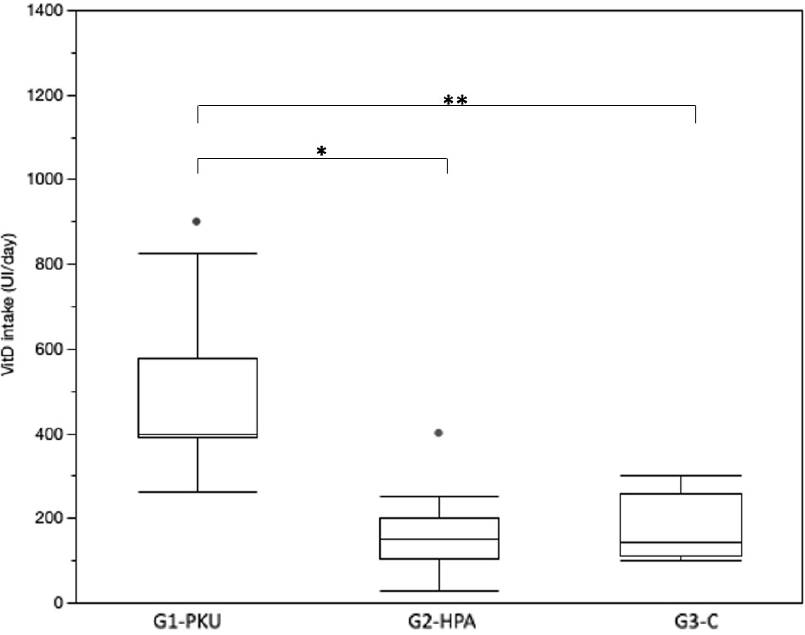
Figure 3. Intake Vitamin D for groups. Intake vitamin D for three groups of patients: Group 1: PKU, Group 2: HPA and Group 3: Control (n = 48). Groups were compared by Kruskal-Wallis test. The horizontal middle line represents the median and 95% confidence interval (CI). A significant difference is observed between G1-PKU and G2-HPA (*p=<0.05); G1- PKU and G3-C (**p=<0.05). 2507), G2-HPA= 744 mg/day (95% CI, 610; 991) and G3-C=978 mg/day (95% CI, 724; 1032) of Ca, with statistically significant differences found between G1-PKU and G2-HPA (p<0.05) and between G1-PKU and G3-C (p<0.05) (Figure